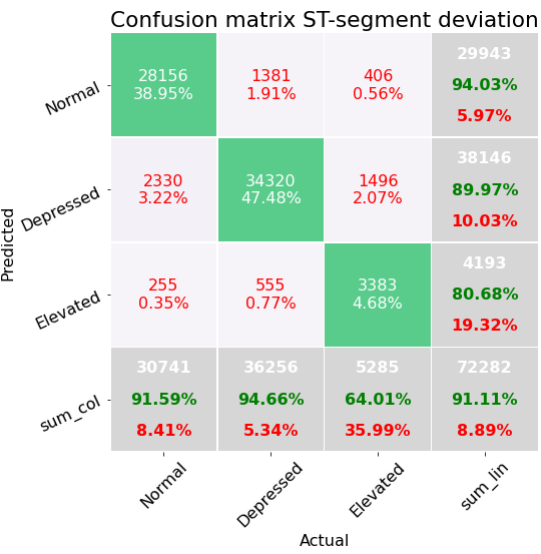
Figure 4. Confusion matrix on the modeling containing the features concerning the distances between the waves of the ECG beat.